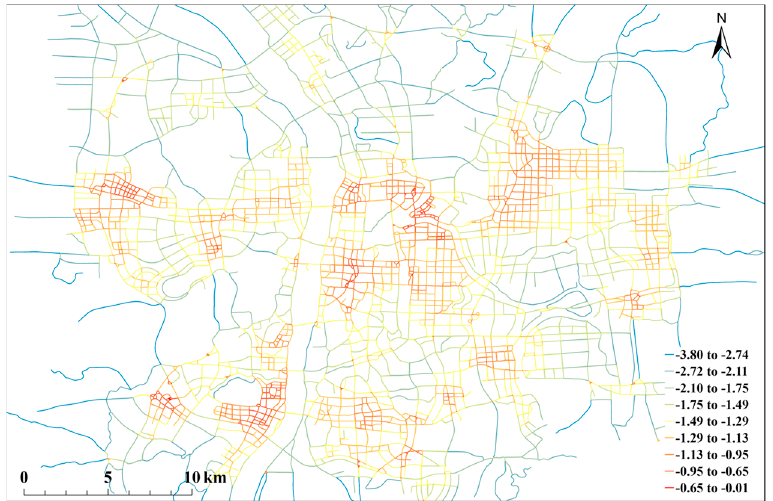
Figure 6. Map of closeness within a search radius of 1870 m from low (cool colors; blue-violet) to high (warm colors; orange-dark red); high values of closeness indicate that the link has good accessibility.